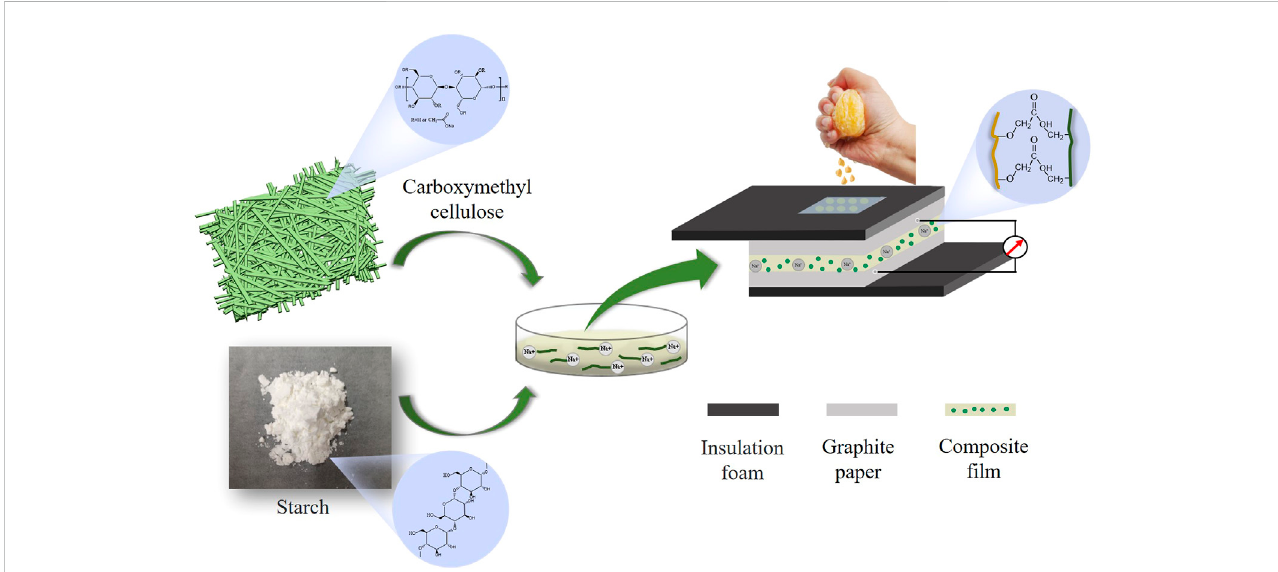
Schematic diagram of the structure of the starch/CMC composite fi lm applied to the rapid detection of juice